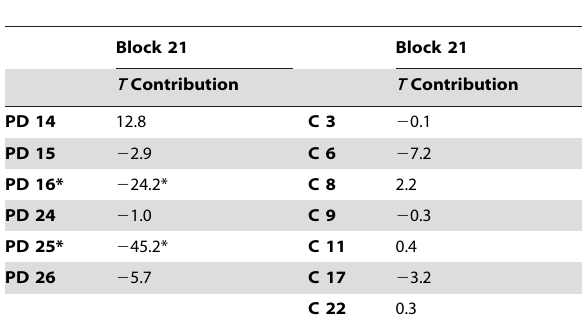
Table 4. Contribution of Tolerance ( T ) to performance change from the last block of practice to the first block of the long-term retention session of patients (PD) and control subjects